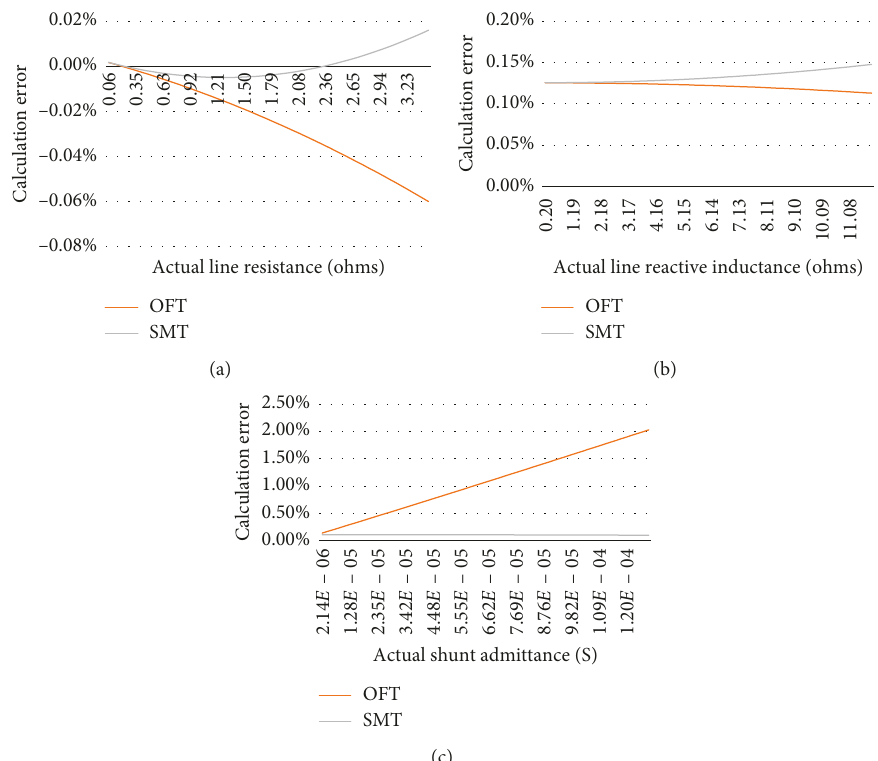
Figure 7: Calculation average errors of the six loading scenarios for the OFT and SMT techniques under Category 2. (a) Resistance. (b) Reactive inductance. (c) Shunt